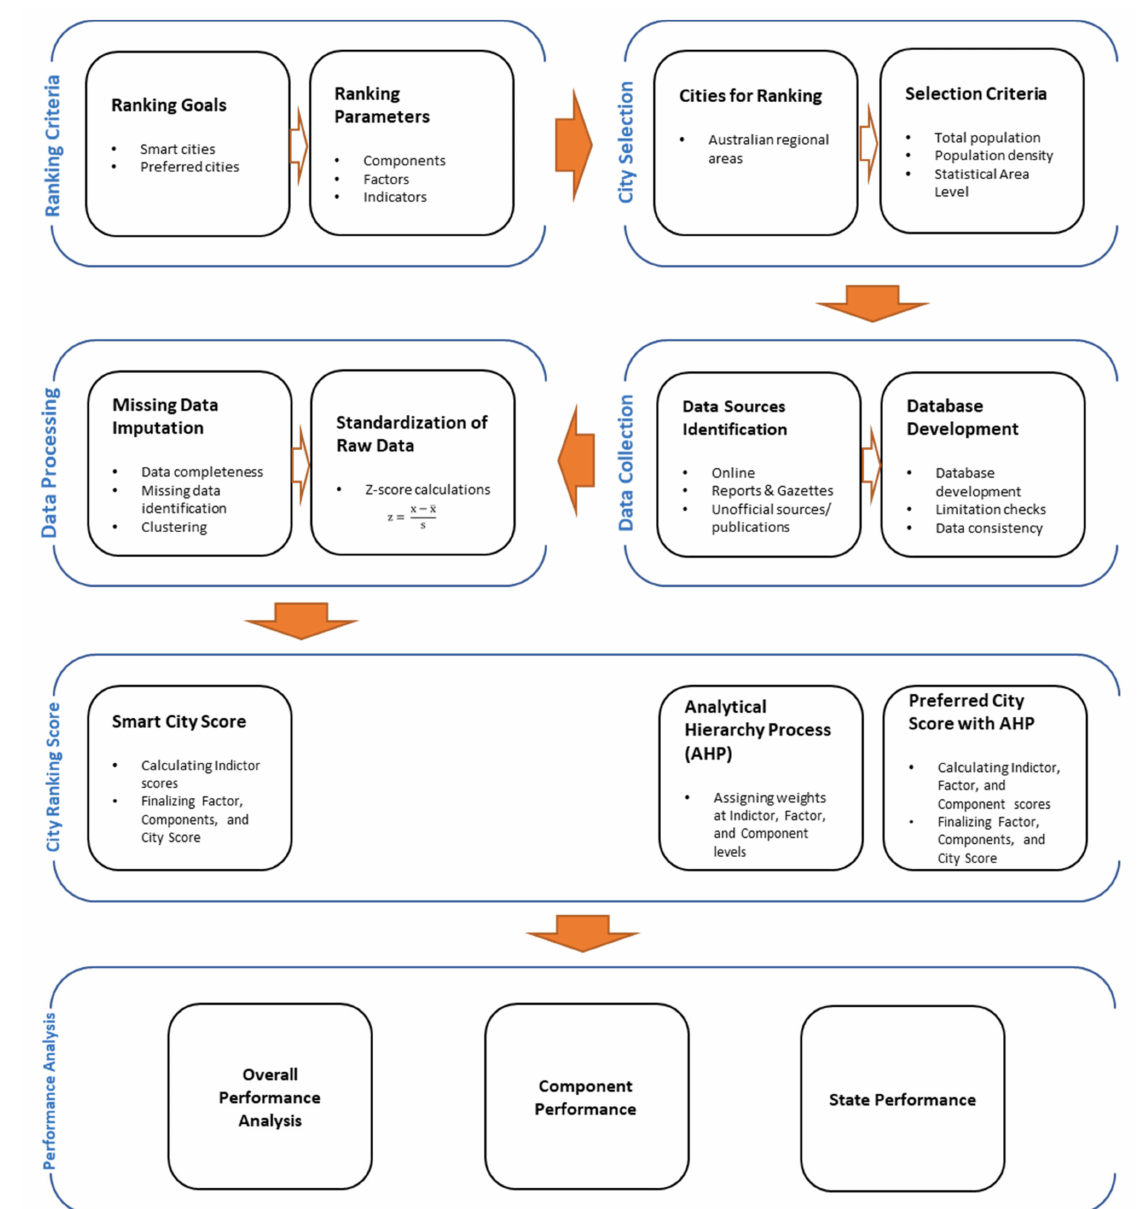
Figure 1. Schematic layout of defined